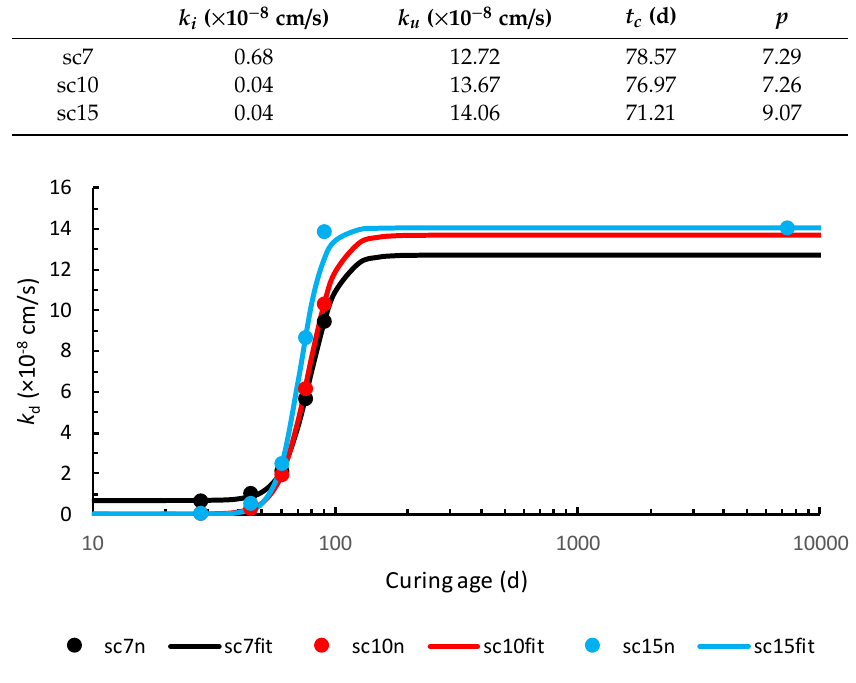
Figure 3. Fitting curves for the evolution of k d in time.